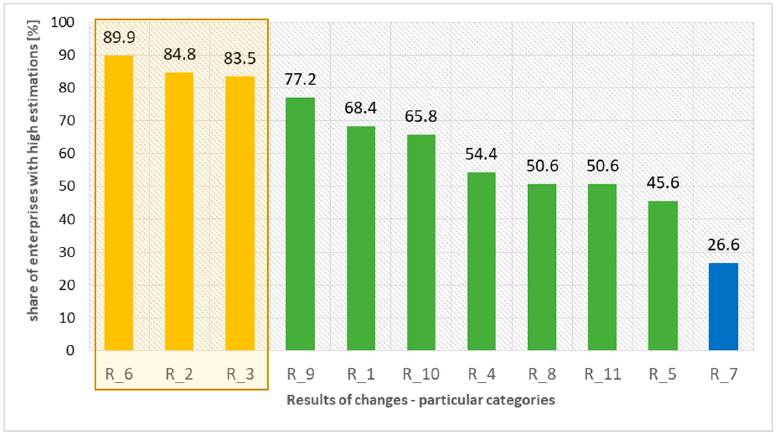
Figure 4. Ranking of the impact of SM projects on enterprise operations based on high scores. Source: own research [73].